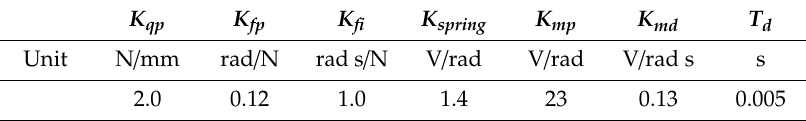
Figure 14. Block diagram of piston control of a pneumatic cylinder. Table 2. Gain parameters of position control of a pneumatic